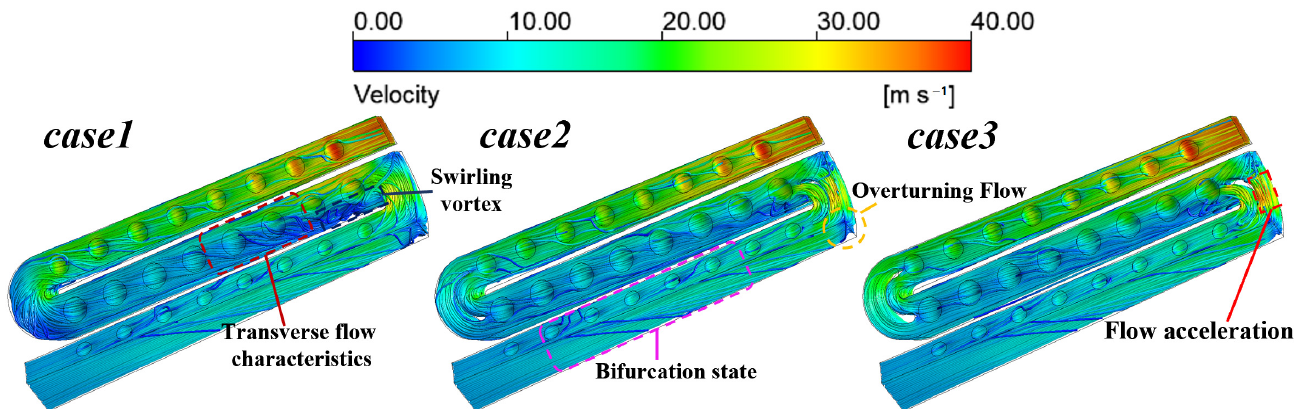
Figure 13. The streamlines of channels, Ro = 0.4.